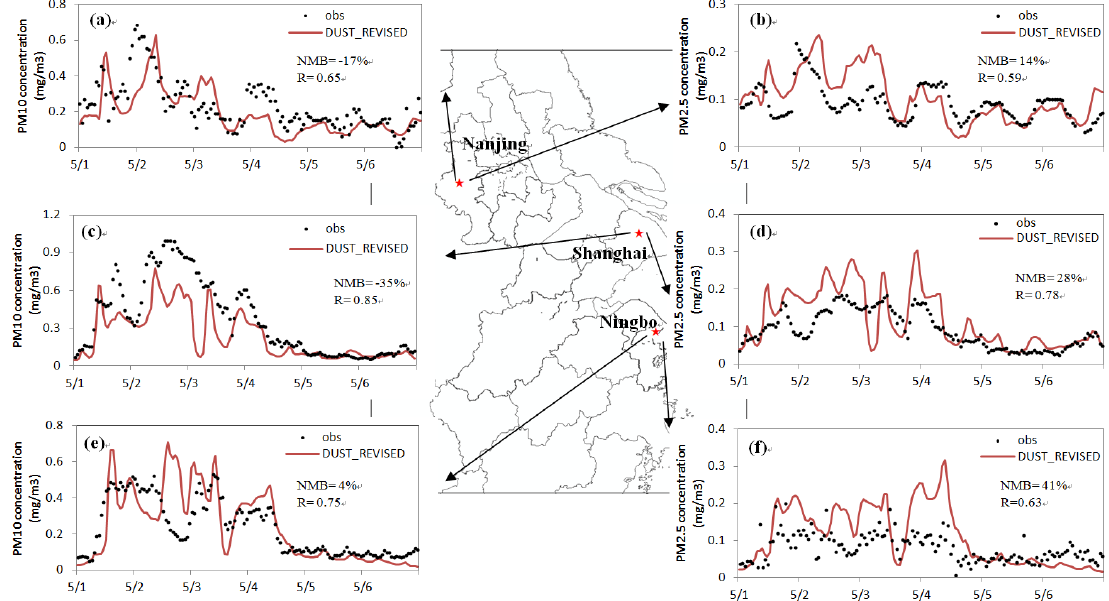
Fig.2. Comparison of simulated PM 10 concentration (a, c, e) and PM 2.5 concentration (b, d, f) with observations at three sites in the YRD Fig. 2. Comparison of simulated PM 10 concentrations (a, c, e) and PM 2 . 5 concentrations (b, d, f) with observations at three sites in the